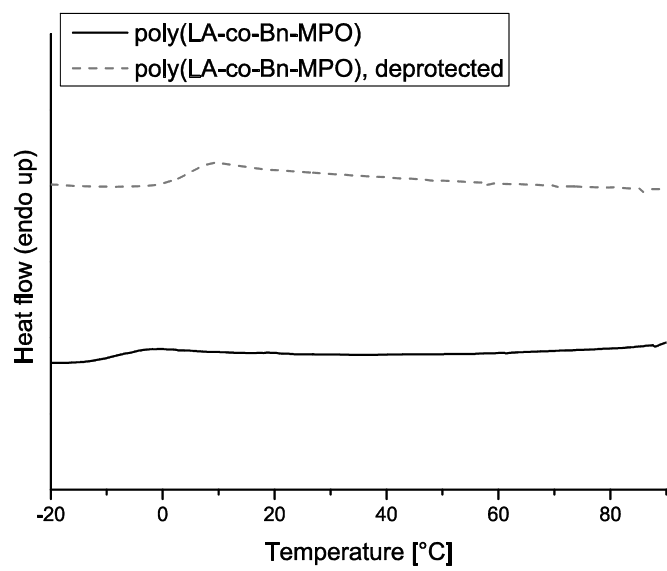
Figure 7. DSC curves for poly(LA-co-Bn-MPO) and deprotected poly(LA-co-Bn-MPO) with a comonomer incorporation of 14.1%.